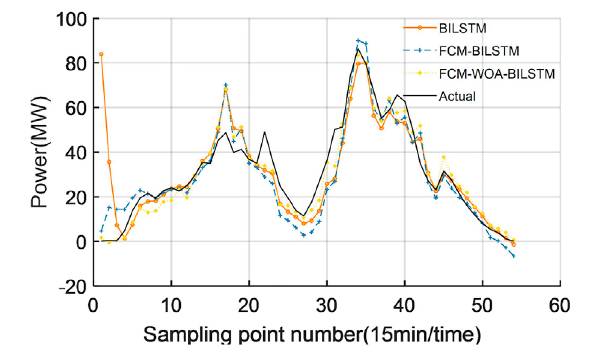
FIGURE 6 | 18 July 2019 (cloudy).